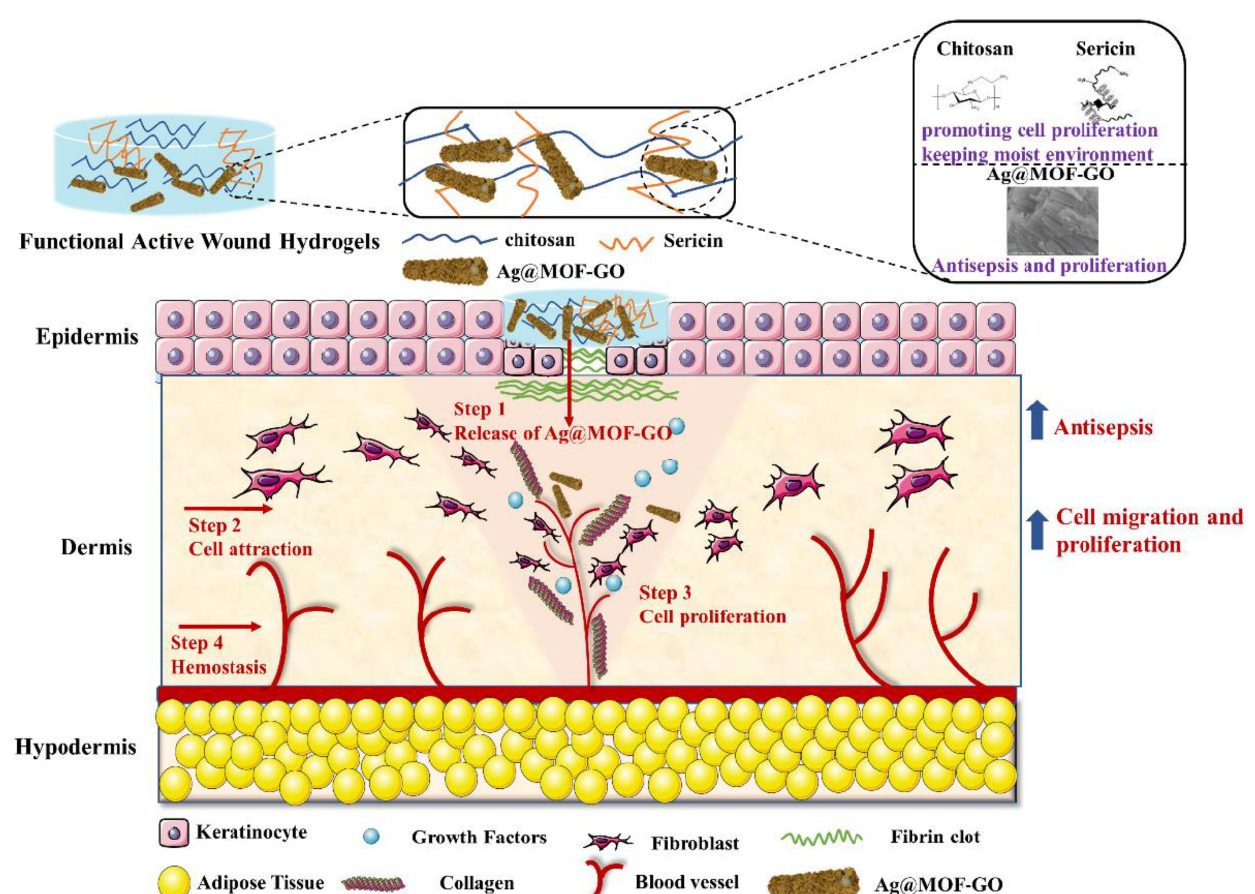
Figure 4. The design of chitosan/silk sericin (CS/SS) hydrogels incorporated with silver nanoparticles @ organic frameworks/graphene oxide (Ag @MOF-GO). Reproduced with permission from [120].